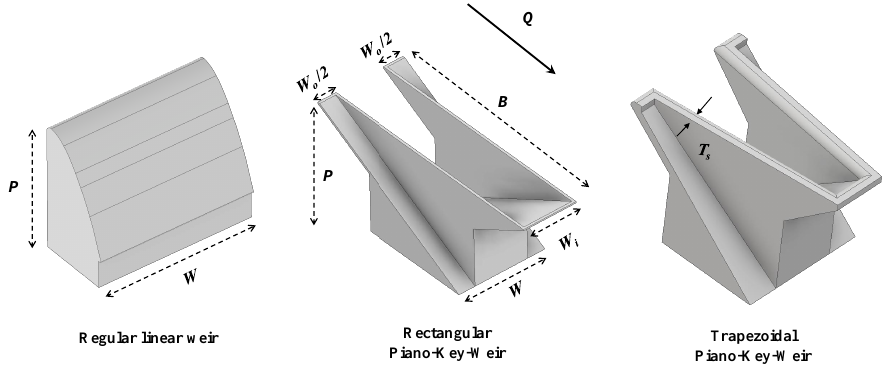
Figure 1. Tested weir configurations, left : regular linear weir, middle : rectangular piano key weir, right : trapezoidal piano key weir.